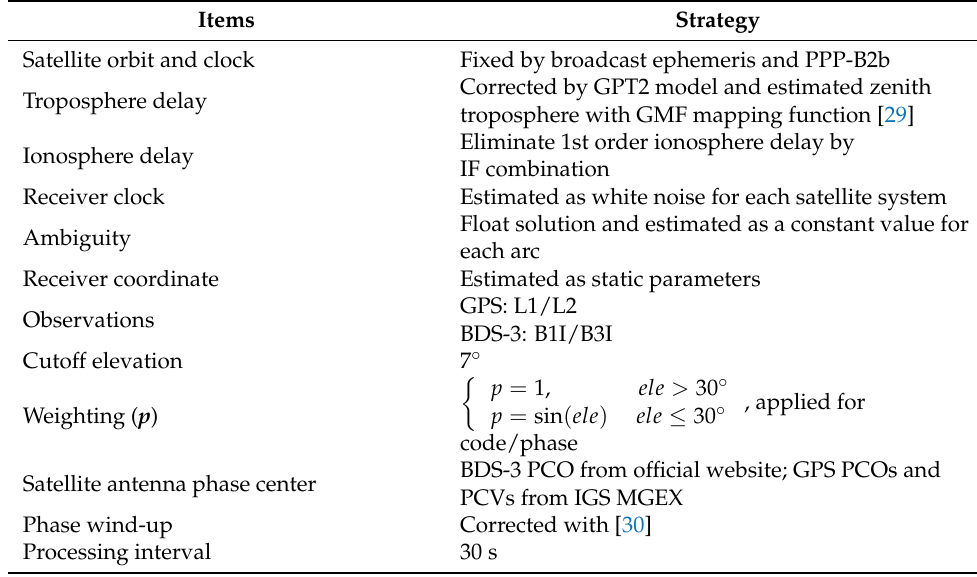
Table 2. PPP processing